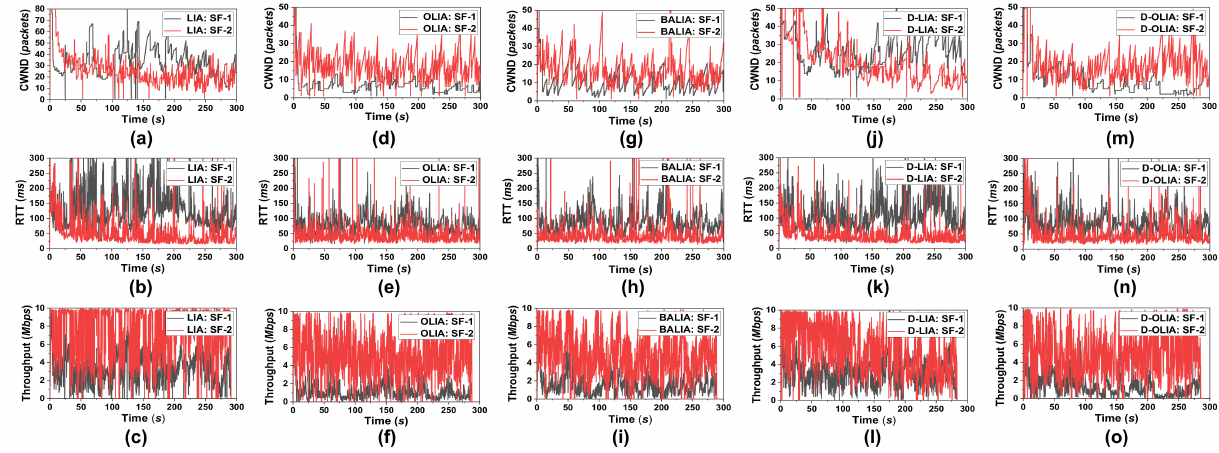
Figure 6. Performance analysis of the considered MPTCP-CCAs for Scenario #2 in terms of CWND, RTT, and throughput for ( a – c ) LIA, ( d – f ) OLIA, ( g – i ) BALIA, ( j – l ) D-LIA, and ( m – o ) D-OLIA.